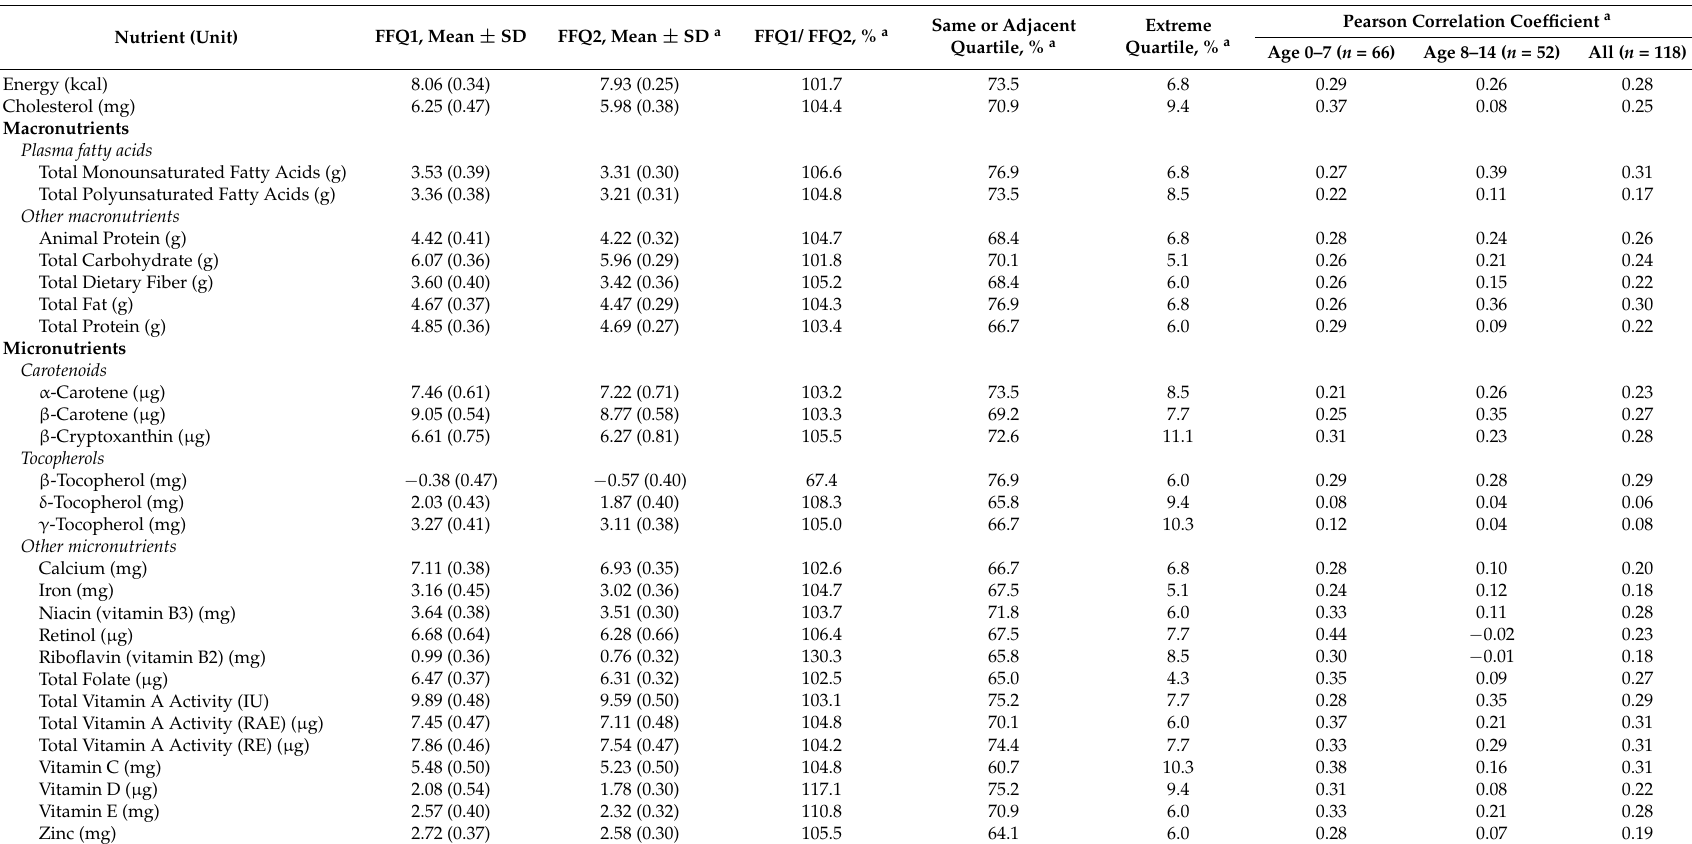
Table 2. Reproducibility of log-transformed energy and nutrients from food frequency questionnaires (FFQs) administered at month 1 (FFQ1) and month 6 (FFQ2) ( N =